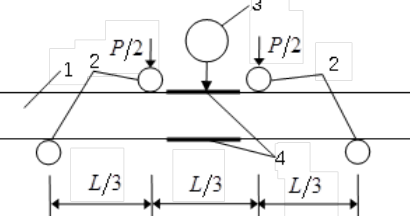
Figure 1: Testing Principle for Tensile, Compression and Flexural moduli (1-beam specimen; 2-cylindrical support; 3-micrometer; 4- strain gage).